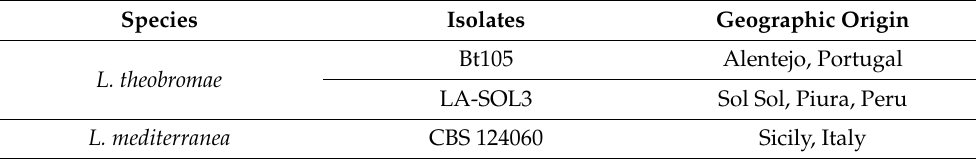
Table 3. Lasiodiplodia spp. isolates used for pruning wound inoculation. Species Isolates Geographic